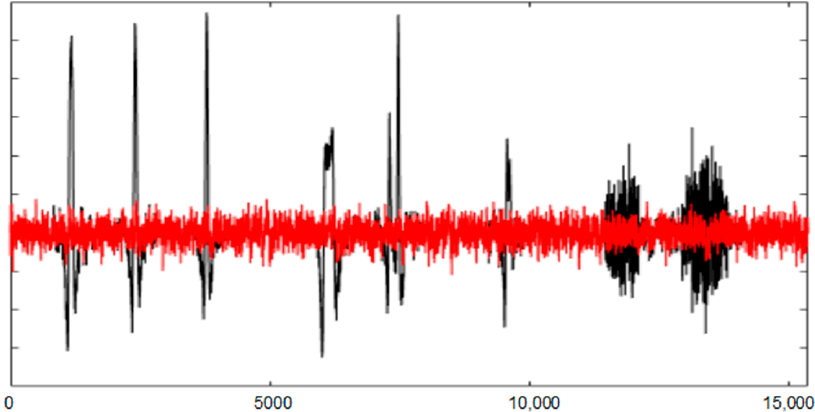
Figure 17. The AF8 channel of SEEG with (in black) and without artefacts (in red) after using UAR. The X axis shows the samples.